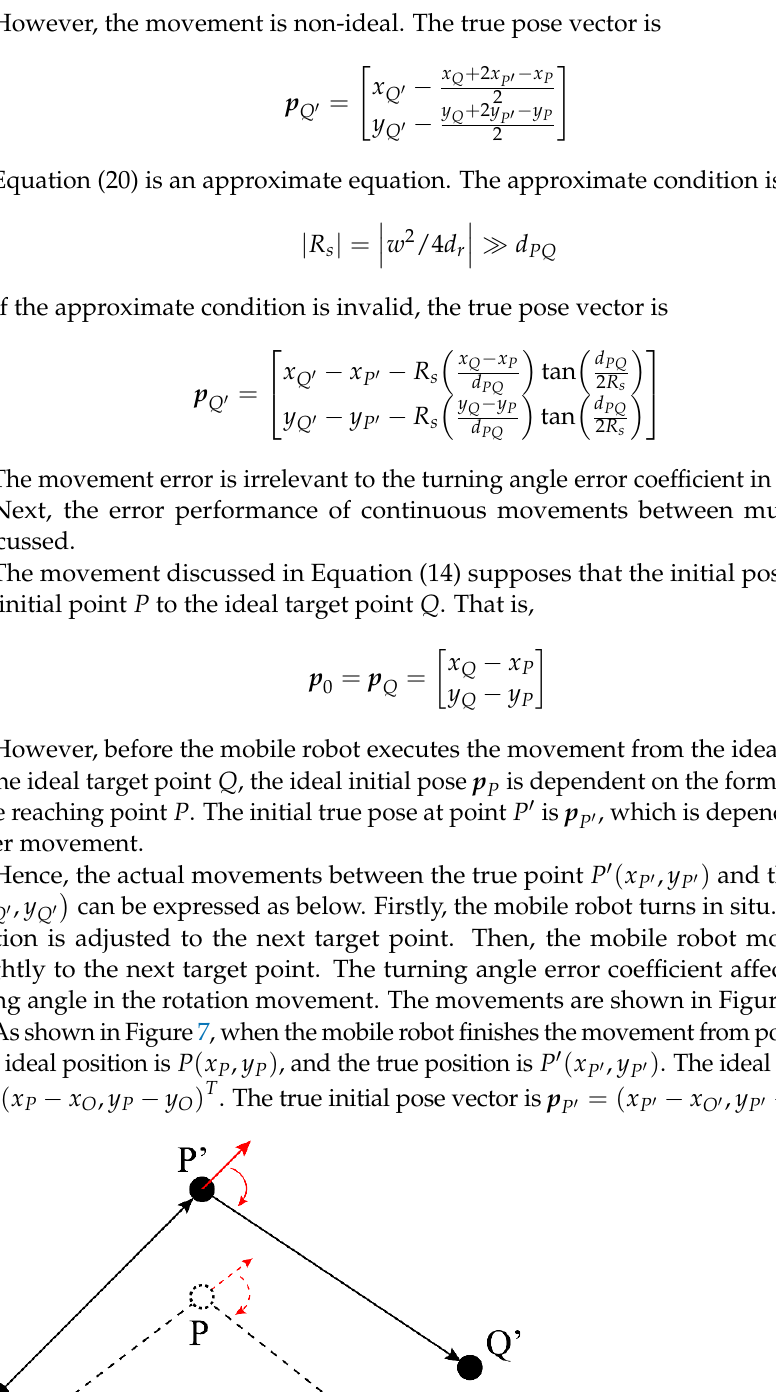
Because of the turning angle error coefficient,